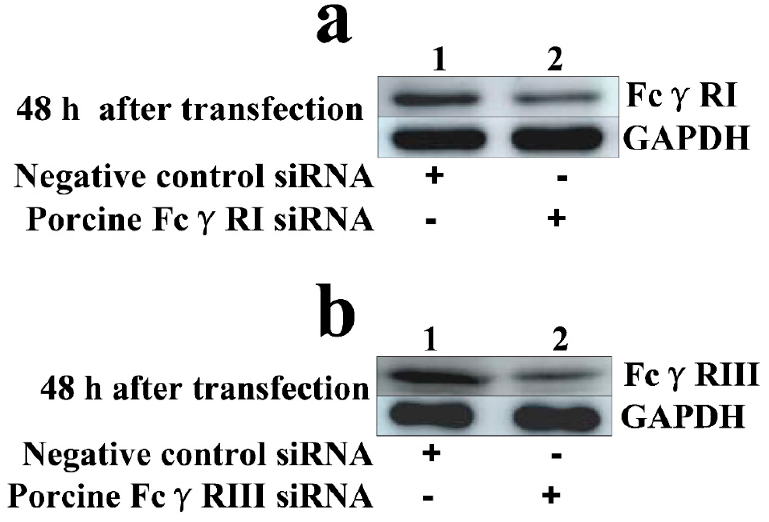
Figure 3. Analysis of the total cellular protein expression of Fc γ RI or Fc γ RIII in PAMs. PAMs cells were transfected with porcine Fc γ RI or Fc γ RIII siRNA for forty-eight hours and then used for the analysis of immunoblot. The total cellular protein level of Fc γ RI ( a ) or Fc γ RIII ( b ) in transfected cells was quantified by Western blot. The original version of the Western blot can be seen in Supplementary Materials. The GAPDH was used as a reference protein.